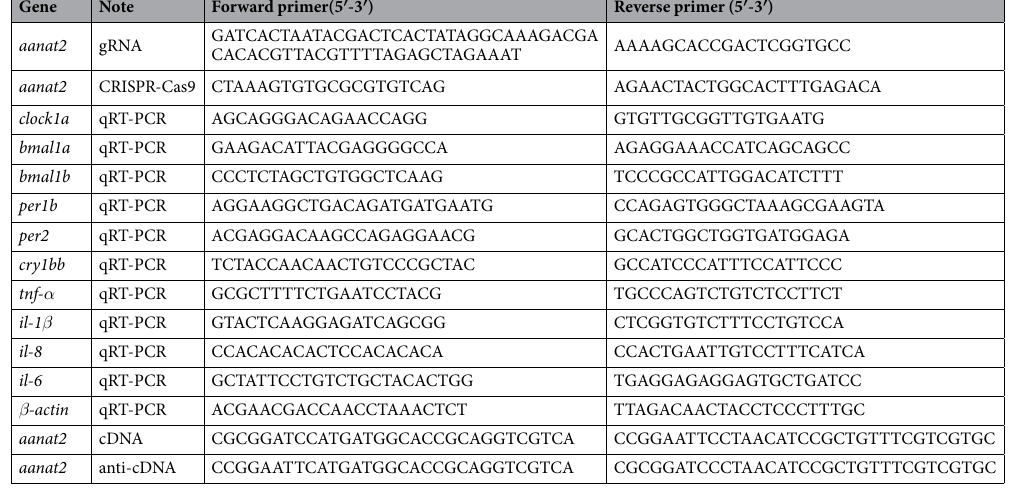
Table 1. Primers used in the